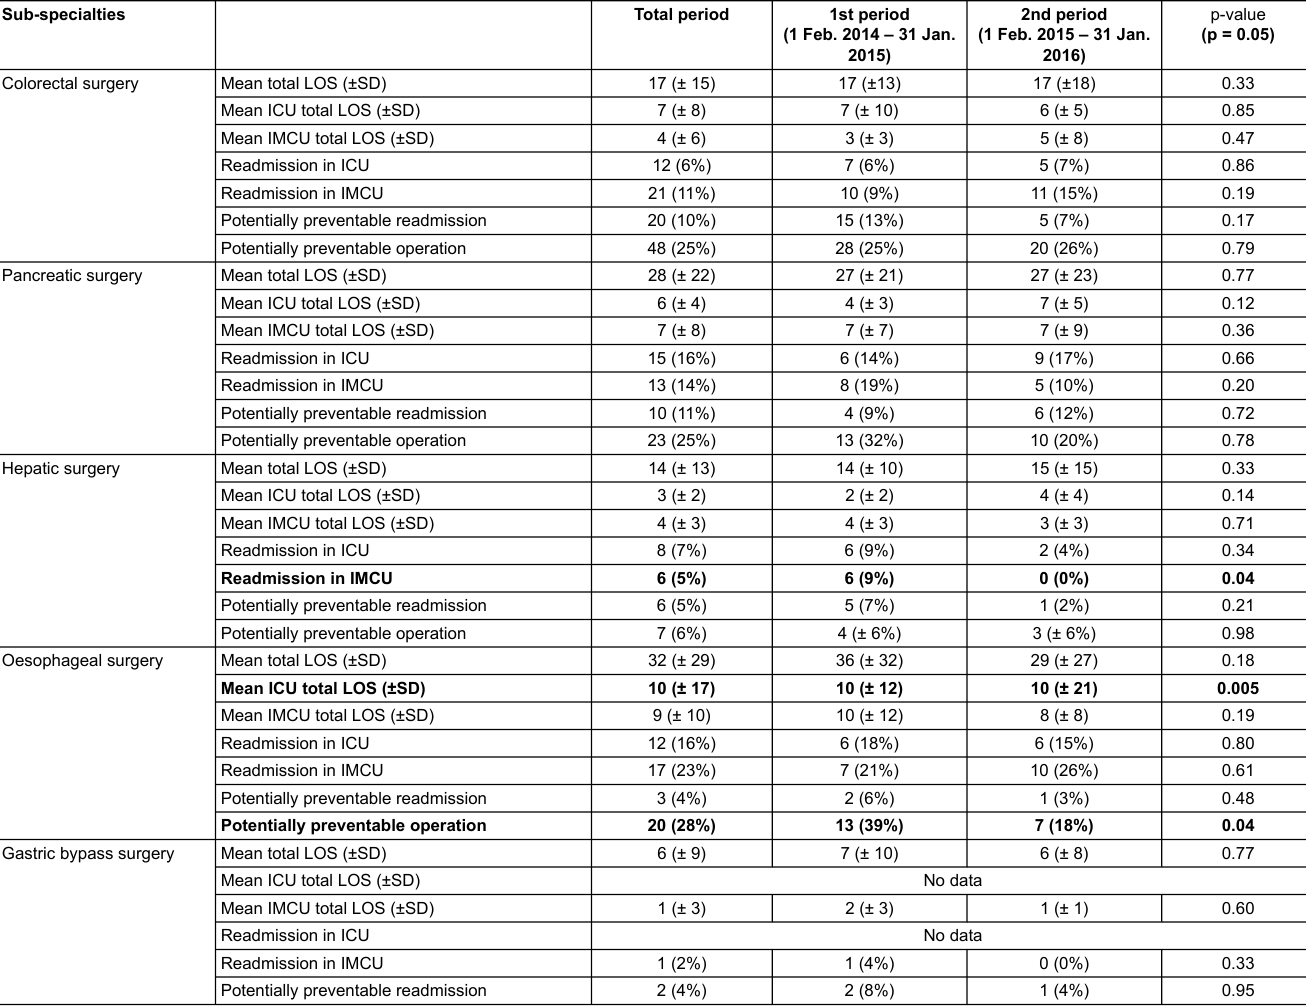
Table 3: Details of the ICU, IMCU LOS, readmissions in ICU or IMCU and potentially preventable readmission and operation.